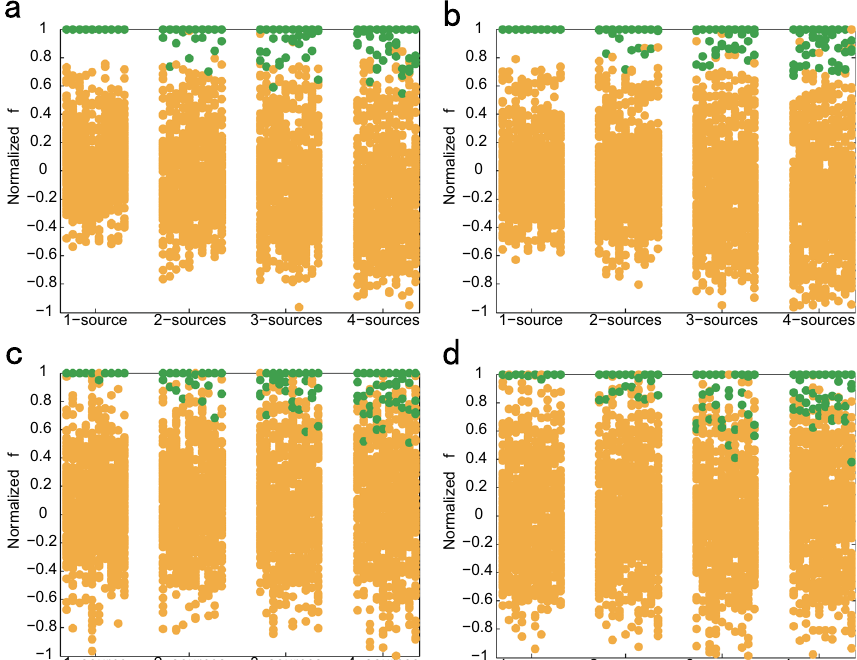
Figure 3. Normalized f value of nodes. We execute experiment on ER and BA networks with n = 100 and average degree � k � = 4 . For diffusion dynamics in ( a ) and ( b ), the time delay of edges follows Gaussian distribution N ( u , σ 2 ) with u = 2 and σ = 0.25 and we set informed rate as (cid:31) = 0.5 for SI dynamics in ( c ) and ( d ). Randomly select 50% of nodes as observer nodes. Abscissa is the number of sources, ordinate is normalized f value. We randomly selected sources have the same initial time as 0 and 10 repetitive experiments are executed for each number of source. Clearly, for all cases, the values f of true sources remain larger than which of non- sources. All f values are normalized and each value is divided by the maximum f value of each node. ( a ) and ( c ) are BA network, ( b ) and ( d ) are ER network.